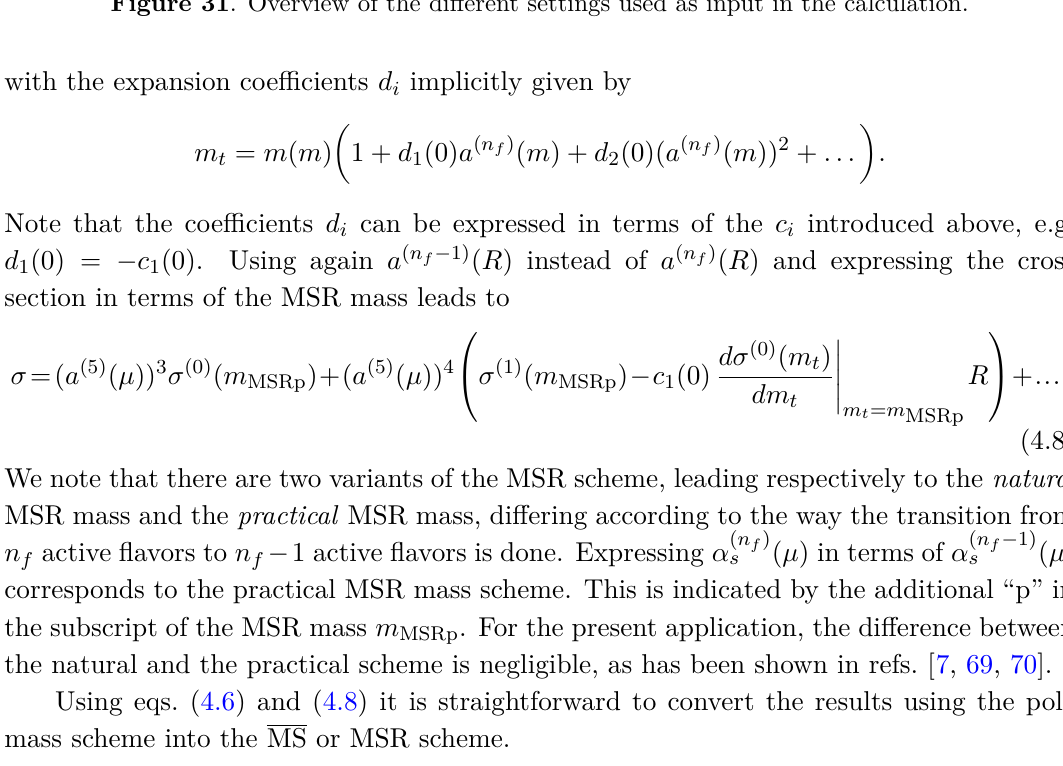
Figure 31 . Overview of the different settings used as input in the